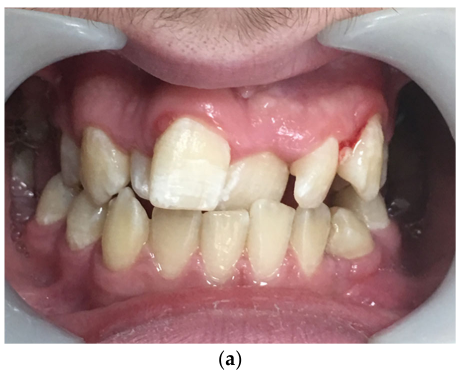
Figure 1. ( a – g ) The preoperative panoramic radiograph following the removal of the four first pre ‐ molars, showing impacted and distally angulated mandibular second premolars ( a ) and the pre ‐ operative views of the surgical exposure site ( b , c ), one week after diode laser exposure (940 nm). Bonding with simultaneous traction using power chain, absence of inflammation or swelling one week post ‐ op ( d ), subsequent re ‐ bonding with premolar brackets, and final result are shown ( e – g